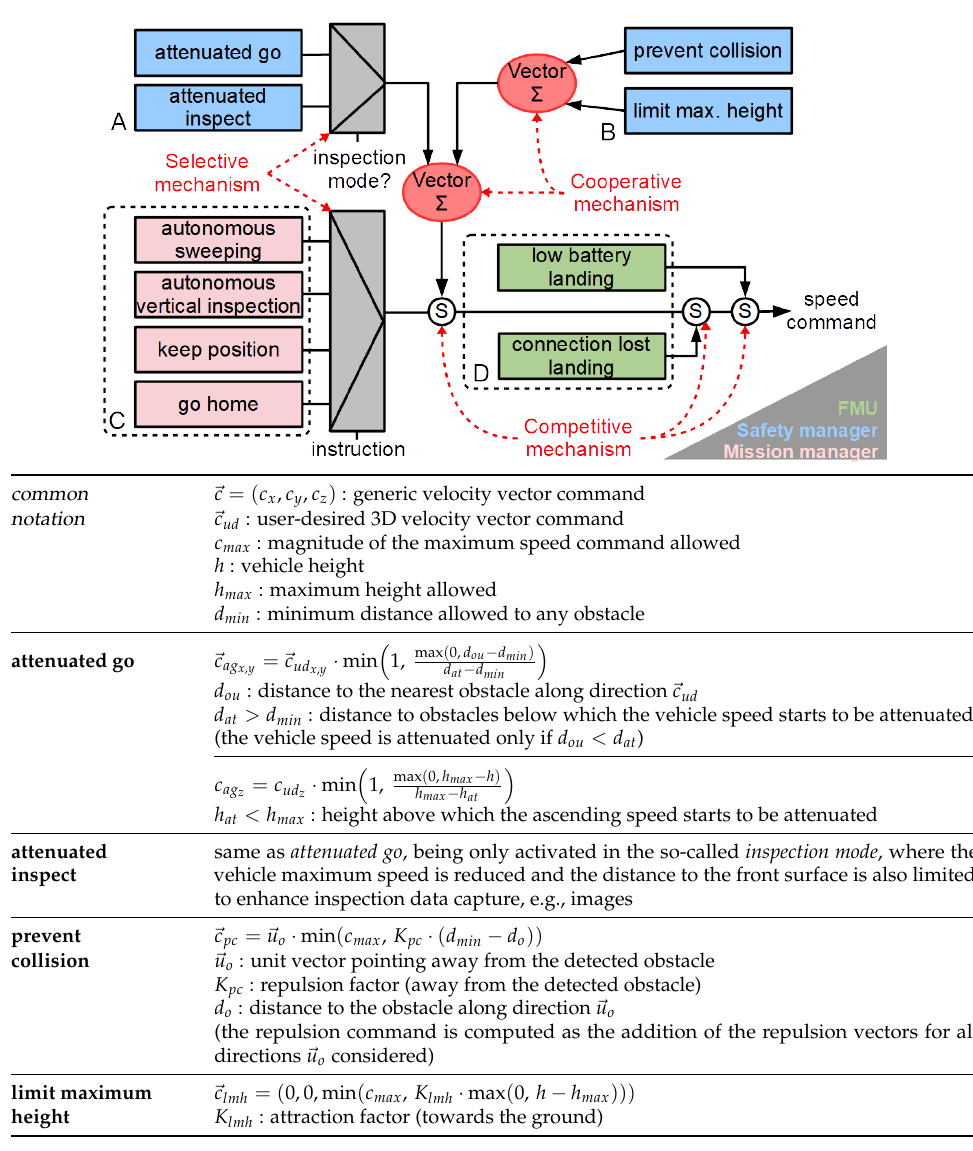
Figure 7. Behaviour-based architecture: ( A ) groups behaviours to accomplish the user intention, ( B ) groups behaviours that ensure the platform safety within the environment, ( C ) groups behaviours that increase the autonomy level, and ( D ) groups behaviours oriented to check flight viability. Be- haviour combination mechanisms are highlighted with red arrows. The formulation of the behaviours adopting a potential fields approach is at the bottom table. On-board obstacle detection sensors supply the distances to surrounding